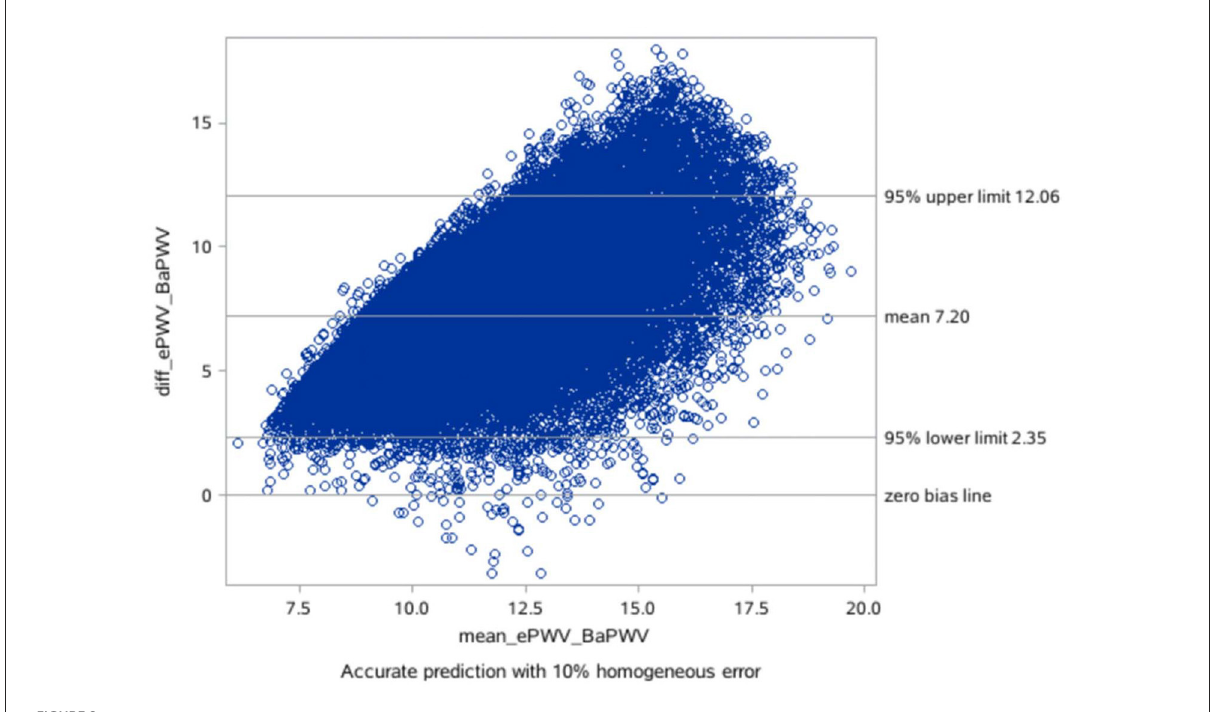
FIGURE2 Bland Altman plot for the consistency analysis between the baPWV and the ePWV.